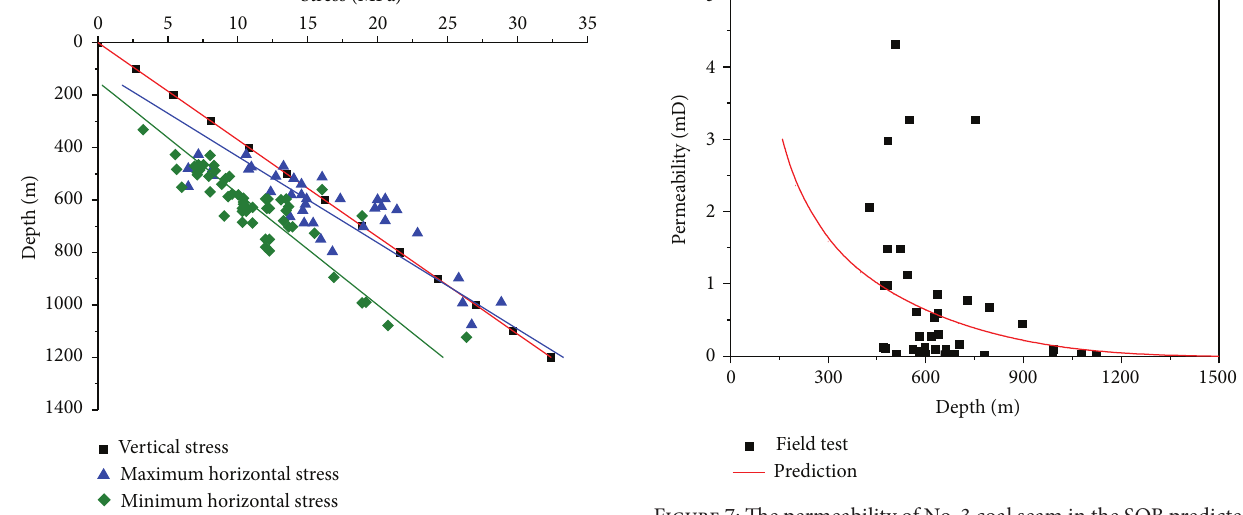
Figure 7: The permeability of No. 3 coal seam in the SQB predicted and tested in field.